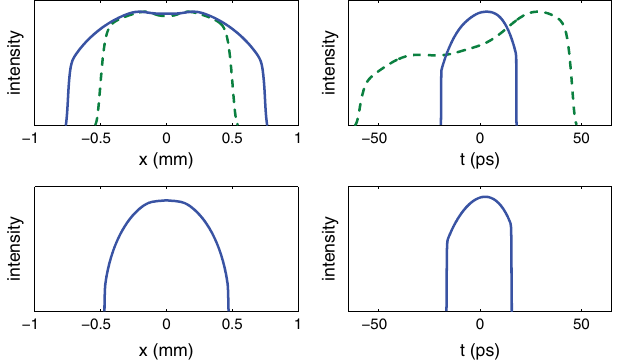
FIG. 9. (Top row) The optimal shape for the dc gun for two different laser pulse lengths, 10 ps (solid) and 30 ps rms (dashed line). (Bottom row) The optimal shape for the SRF gun.